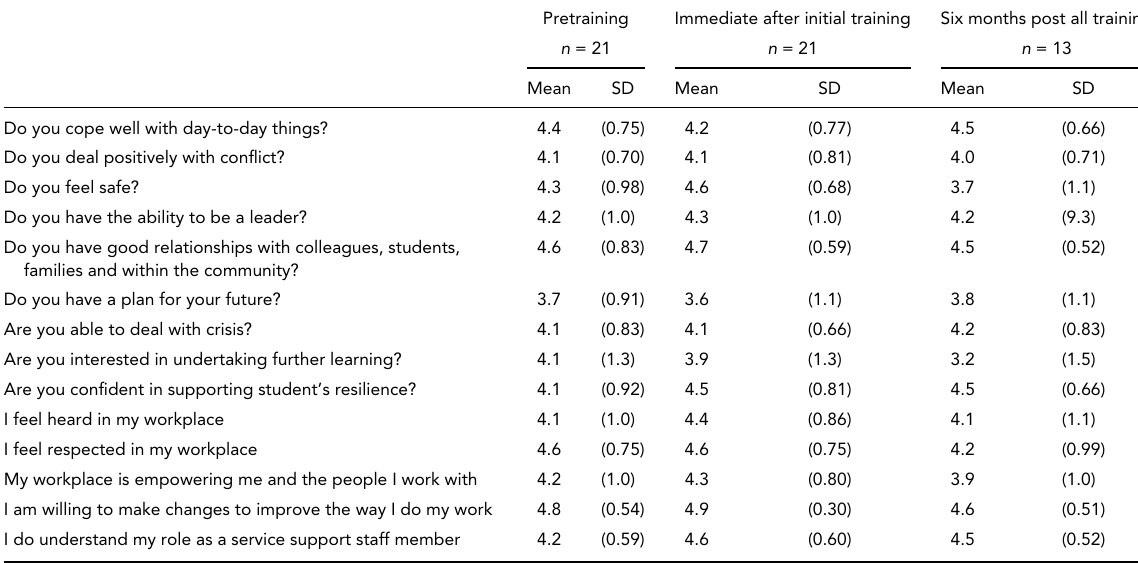
Means and Standard Deviations (SD) of Workplace Empowerment Indicators at Each Measurement Point Pretraining Immediate after initial training